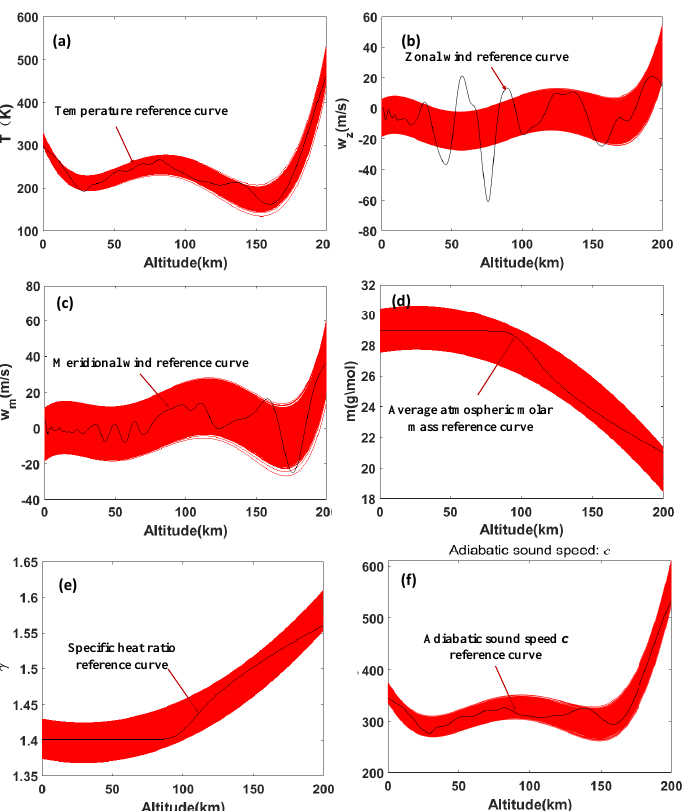
Figure 5. Distribution curves of each atmospheric parameter generated after Sobol sampling (the number of sampling is 1200). The black line represents the reference atmospheric parameter distribu- tion curve, and the red line represents the atmospheric parameter distribution curve generated after sampling. Graphs ( a – f ) illustrate temperature T , zonal wind speed w z , meridional wind speed w m , average atmospheric molar mass m , specific heat ratio γ , and adiabatic sound speed c , respectively (Data from: https://kauai.ccmc.gsfc.nasa.gov/instantrun/msis, accessed on 15 May